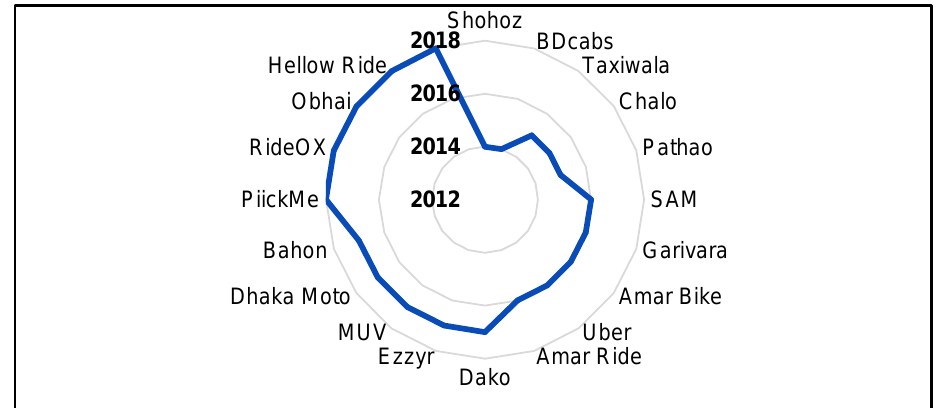
Fig. 3. Flowchart showing the launching years of the ride-sharing companies in